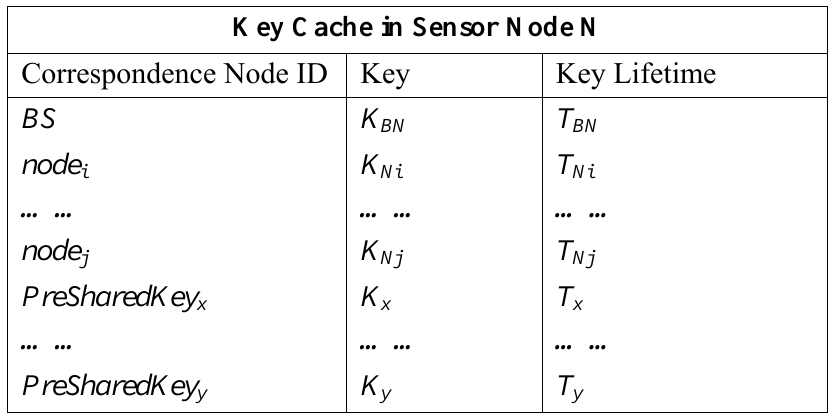
Table 1. The structure of Key Cache.